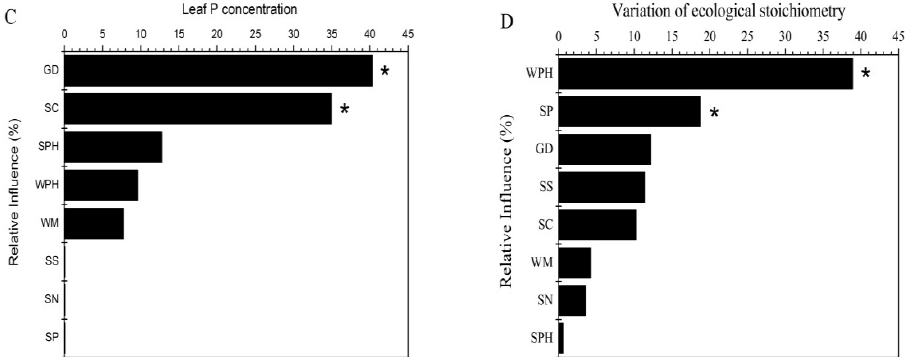
Figure 4. Relative influences of environmental factors on variations in leaf C, N, and P concentrations as well as ecological stoichiometry of A. sparsifolia in the study sites. GD, groundwater depth; WPH, groundwater pH; WM, the degree of mineralization of groundwater; SS, soil salt; SPH, soil pH; SC, soil C concentration; SN, soil N concentration; SP, soil P concentration; PC, plant C concentration; PN, plant N concentration; PP, plant P concentration; PNP, plant N:P ratio. * Indicates significant correlation at p < 0.05. ( A – D ) represent relative influences of environmental factors on variations in leaf C. N, P, and ecological stoichiometry of A. sparsifolia .